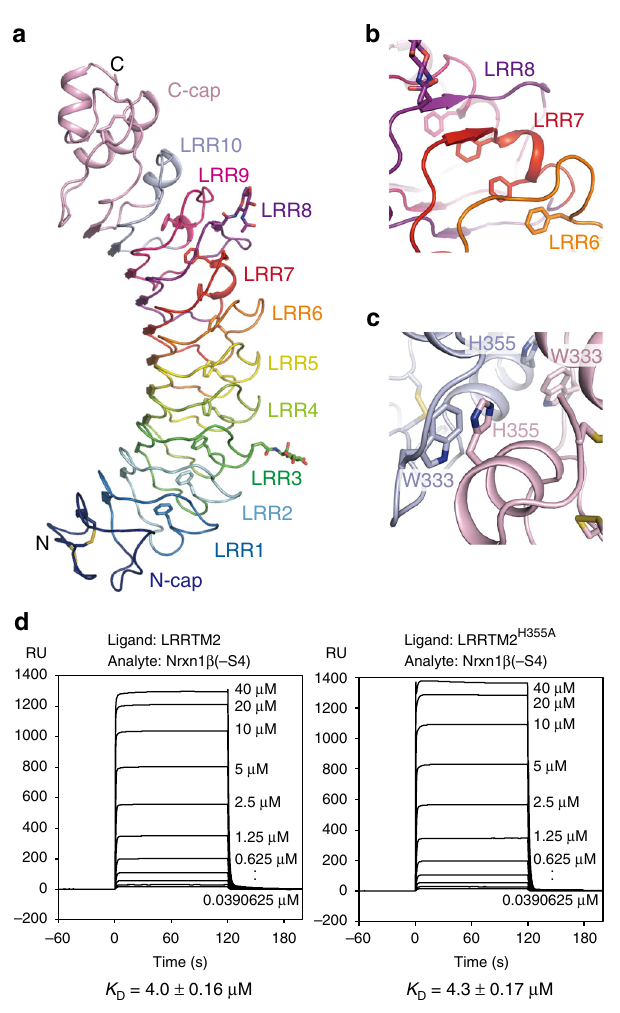
Fig. 1 Structure of LRRTM2 T59L . a Overall structure of LRRTM2 T59L . The N- and C-caps and individual LRRs are colored differently. The N -linked sugar chains, disul fi de bonds, and phenylalanine residues consisting of the Phe spine are shown as sticks. b Close-up view of LRR7-LRR8. Two phenylalanine residues in LRR7 (red) are involved in the Phe spine. LRR8 (purple) lacks a phenylalanine residue for the Phe spine. c Intermolecular interaction in LRRTM2 T59L crystal. Two adjacent LRRTM2 T59L molecules are colored in gray and pink. His355 in one molecule hydrophobically interacts with Trp333 in the other molecule. d SPR analyses of the interaction between Nrxn1 β ( – S4) and LRRTM2. Sensorgrams at different concentrations of Nrxn1 β ( – S4) are similar af fi nities to Nrxin1 β ( – S4) ( K D = 4.3 µM and 4.0 µM, respectively; Fig. 1d). We fi nally succeeded in the co- crystallization of Nrxn1 β and LRRTM2 H355A under the condi- tion without malonate or citrate. The Nrxn1 β – LRRTM2 H355A complex structure was determined at 3.4 Å resolution (Table 1). (Fig. 2a). By analogy with protein – protein interactions mediated by other neuronal LRR proteins 21 – 24 , Nrxn was expected to bind to the concave surface of LRRTM2 18 . On the basis of this assumption and sequence conservation, a previous computational docking analysis predicted that LRRTM2 might interact with Nrxn1 β via the concave surface formed by LRR1 – LRR5 and a part of the N-terminal cap 18 . However, Nrxn1 β binds to the C- terminal cap of LRRTM2 with a buried surface area of 448 Å 2 in the present Nrxn1 β – LRRTM2 structure (Fig. 2a). A calcium ion is